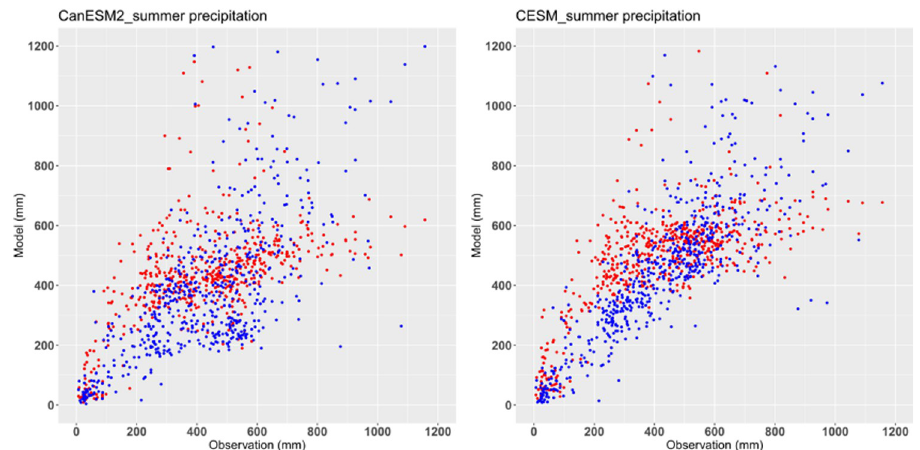
Fig 3. Simulated annual total precipitation in China during current climate in raw and bias-corrected simulation, where red represents the raw simulation and blue represents the bias-corrected simulation.